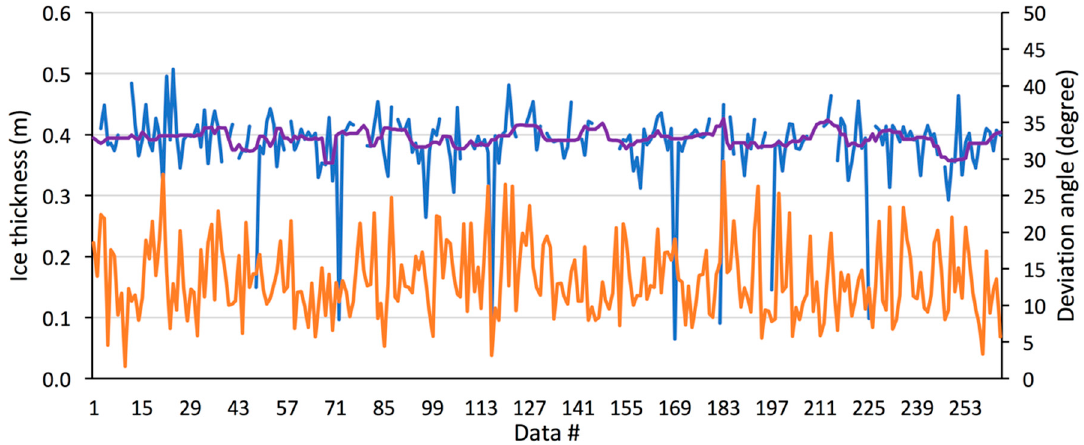
Figure 10. RPA-retrieved radar thickness (blue line, left Y axis), median filtered signal (purple line) and radar viewing angle (orange line, right Y axis) for a stationary flight at 2.5 m above the ice. For the test stationary flight, the mean RPA-based ice thickness was 39.3 cm, compared to the in situ ice thickness of 39 ± 0.5